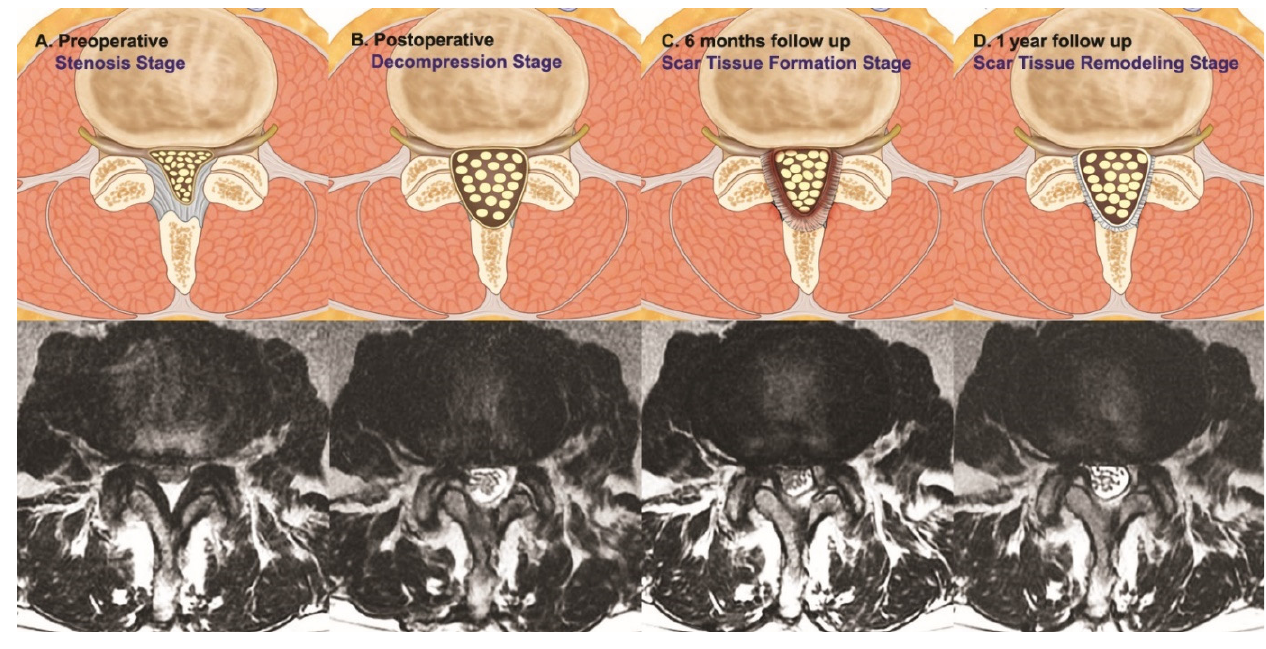
Figure 8. Illustration of the pattern of proposed stages of remodeling and underlying mechanism. The preoperative stenosis stage was relieved by lumbar endoscopic unilateral laminotomy with bilateral decompression to the postoperative decompressed stage. Scar tissue formation at postoperative 6 months led to restenosis at scar tissue formation stage. Further remodeling of the scar tissue was found in postoperative one year follow-up MRI